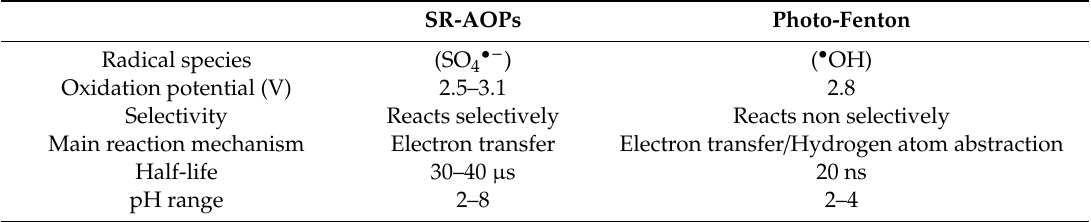
Table 1. Comparison between sulfate radical based AOPs and hydroxyl radical based AOPs such as photo-Fenton